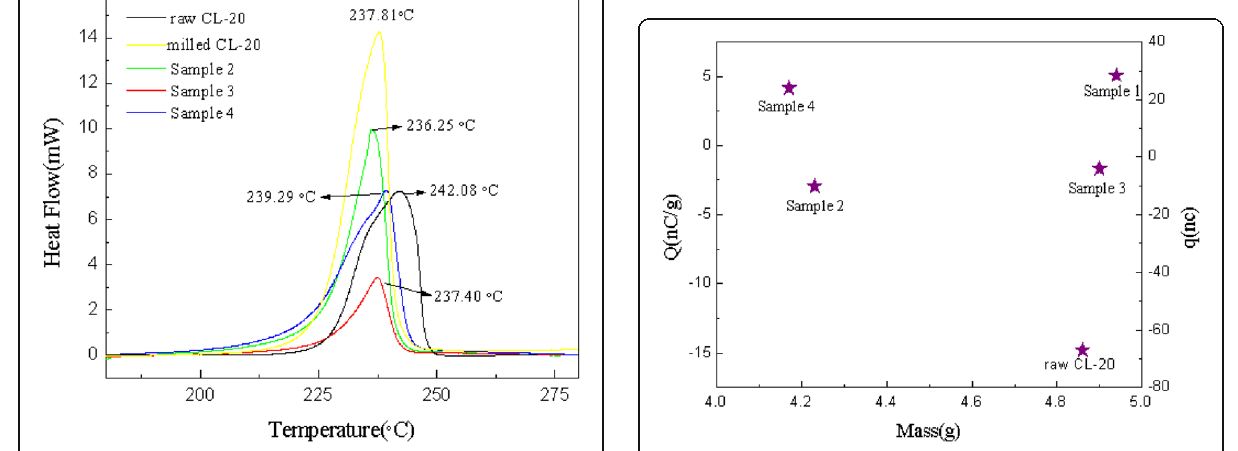
Fig. 6 Static electricity accumulation of